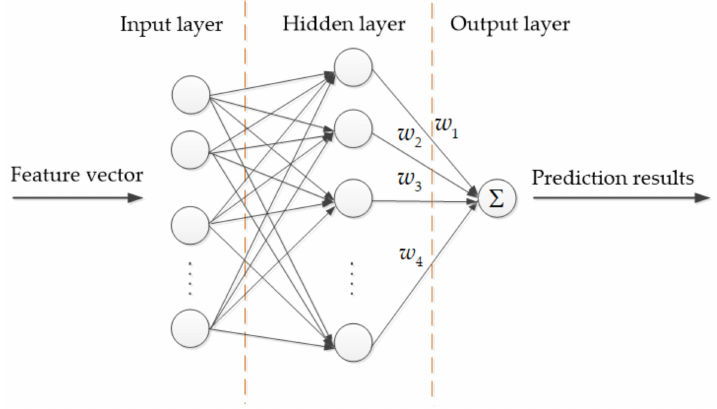
Figure 4. RBF neural